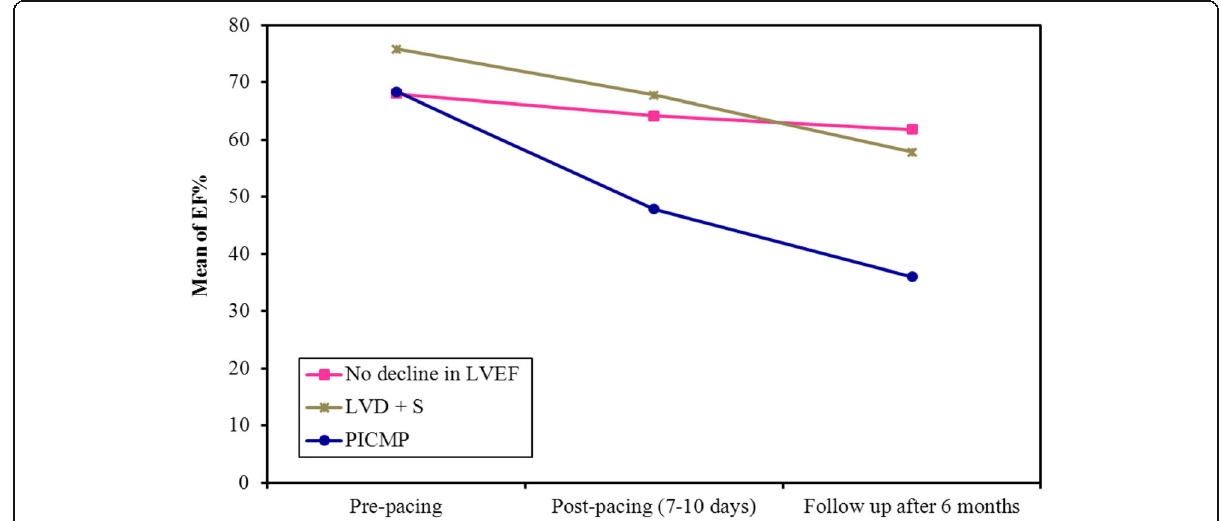
Fig. 1 Comparison between the different periods in each of the three studied groups (no decline in LVEF, PIVD,